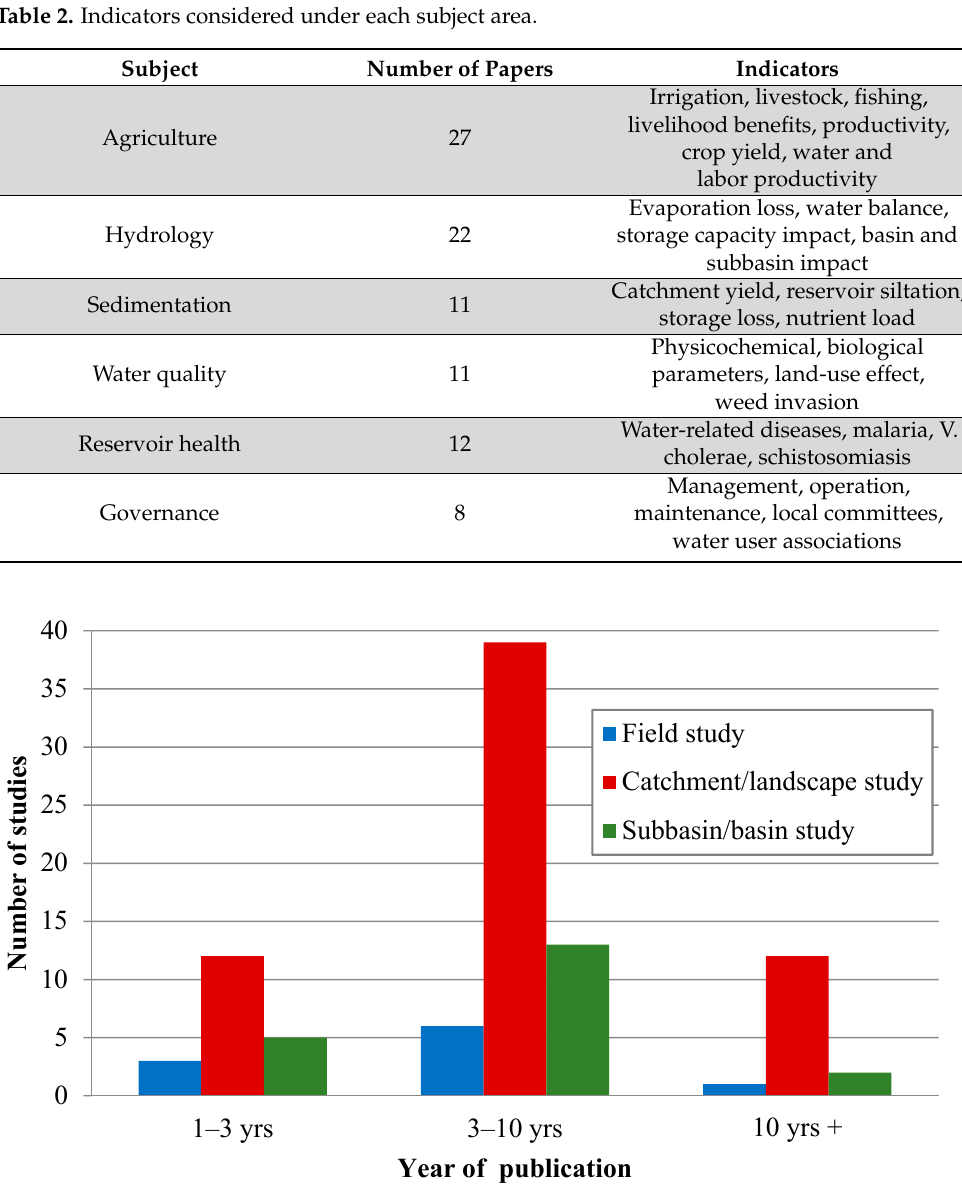
Figure 1. Spatial-temporal representation of the papers reviewed.